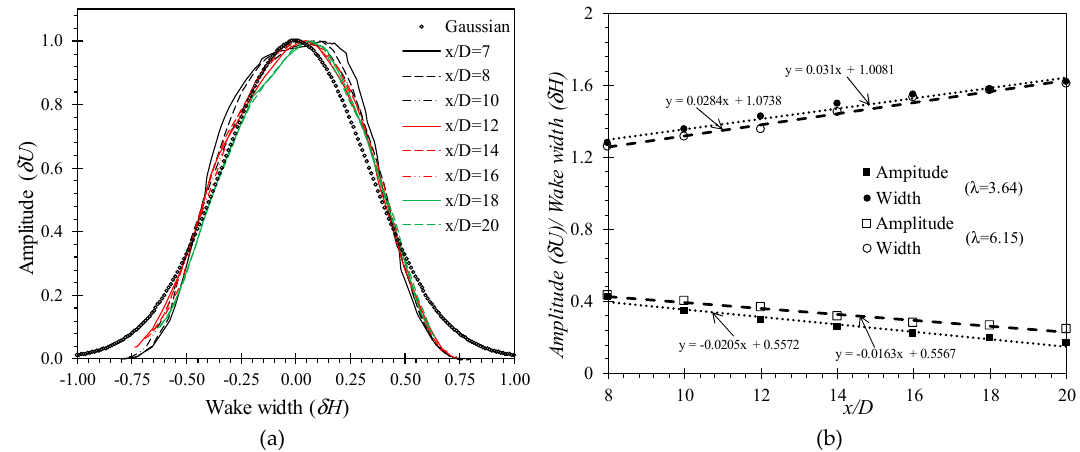
Figure 13. ( a ) Self-similarity in the velocity profiles compared with Gaussian curve for model-scale λ = 6.15 results, and ( b ) variation of the amplitude and wake width in the far wake for λ = 3.64 and 6.15 simulations. In the subfigure ( b ), the dotted and broken lines are the linear curve fit for λ = 3.64 and 6.15 results, respectively. λ = 3.64 results were taken from Salunkhe [36].